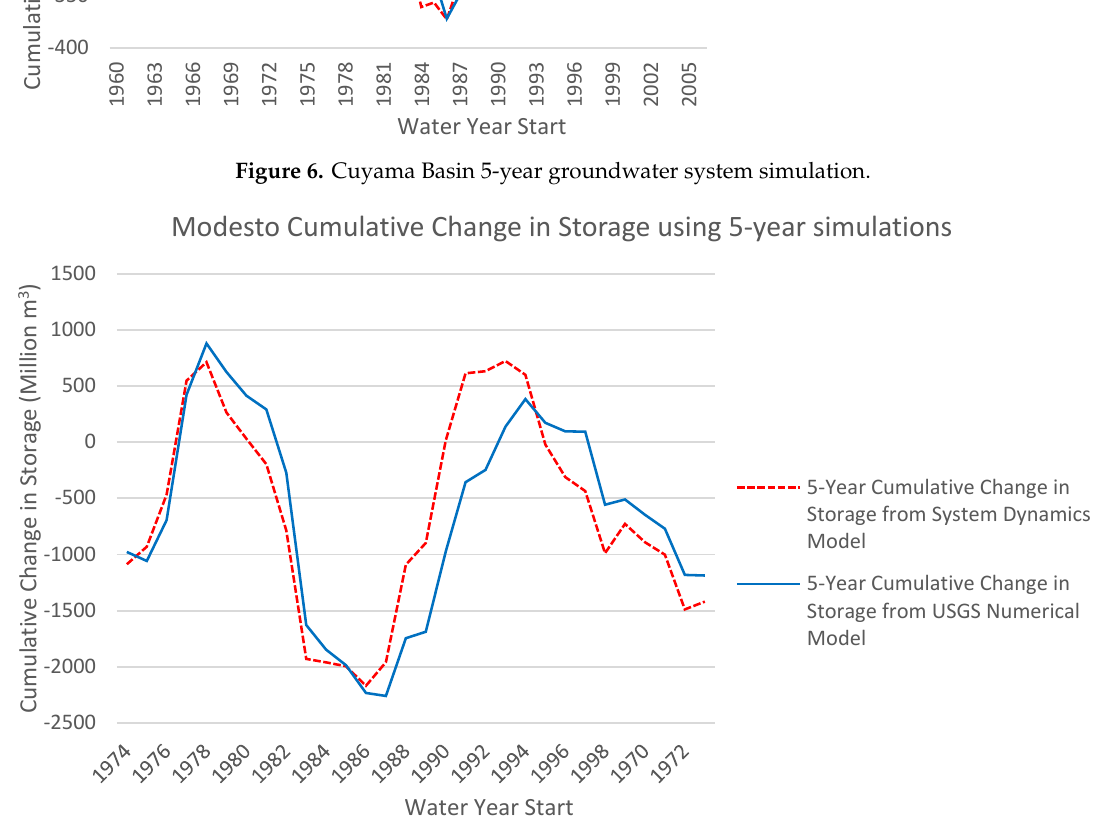
Figure 6. Cuyama Basin 5-year groundwater system simulation.